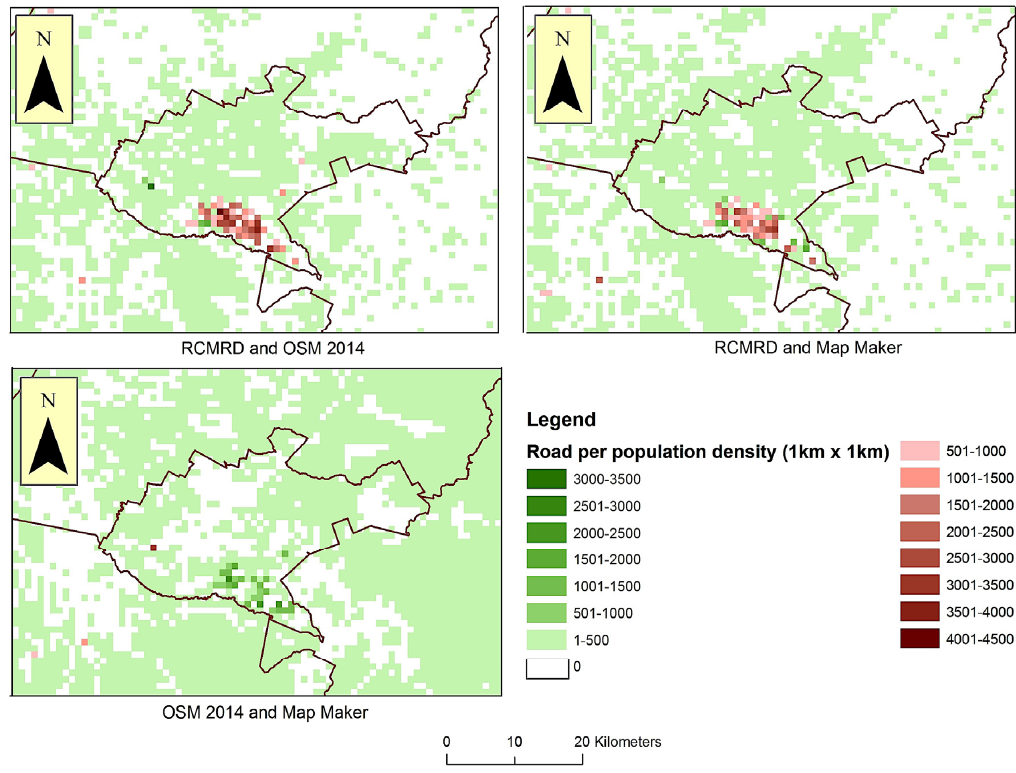
Figure 11. Pairwise difference in roads per population density (green, second layer have higher values; red, first layer has higher values).